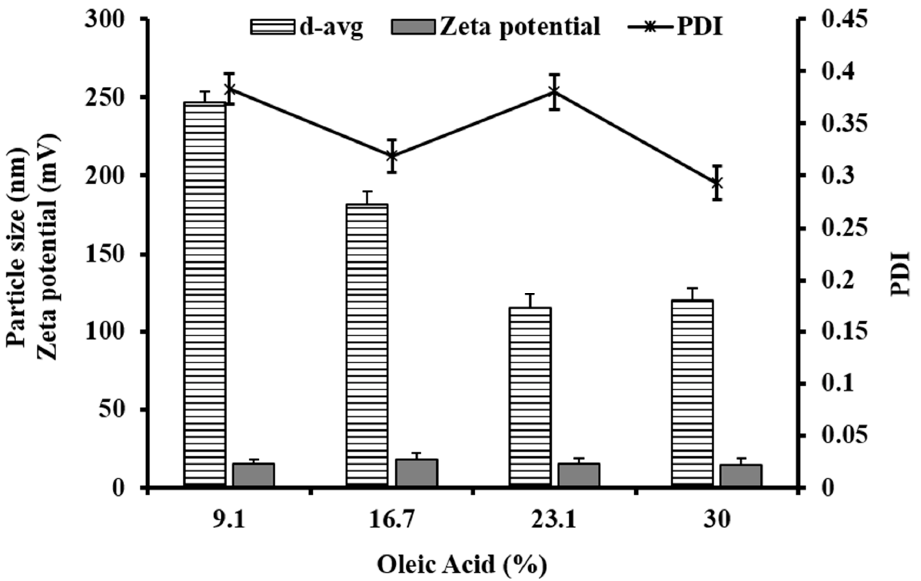
Figure 2. Effect of the amount of oleic acid (% w/w ) on the NLC particle characteristics (d-avg, zeta potential and potential and PDI).